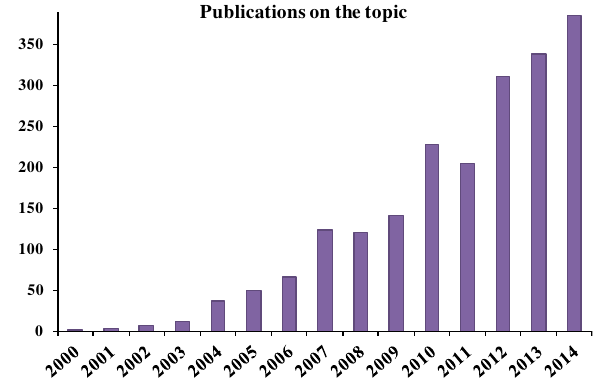
Figure 2. The number of publications on organocatalysis, obtained by searching ‘ organocatalysis ’ in Sci fi nder. For the year 2014, the number has been calculated until December 15th, 2014. See Ref. [23].